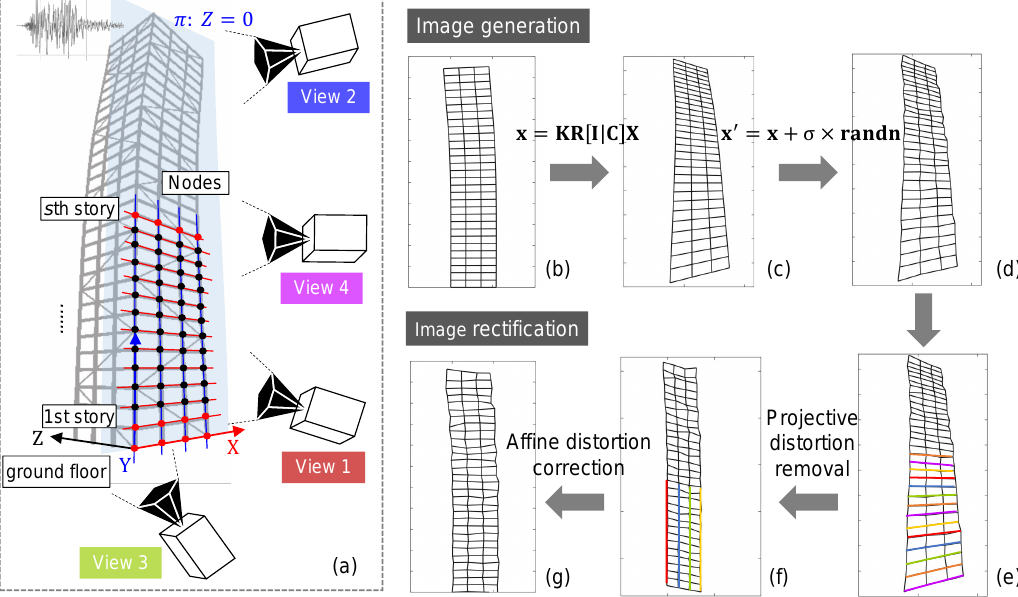
Figure 7. Processes of image generation and image rectification (building deformations are drawn to a scale of ten for enhanced visualizations): ( a ) positions of the camera, ( b ) world plane Z = 0, ( c ) synthetic image after camera projection, ( d ) image perturbed with noise, ( e ) image with line detection, ( f ) image after projective distortion removal, ( g ) image after affine distortion correction.